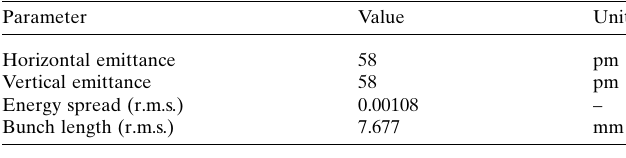
Table 2 Particle distribution at the equilibrium.